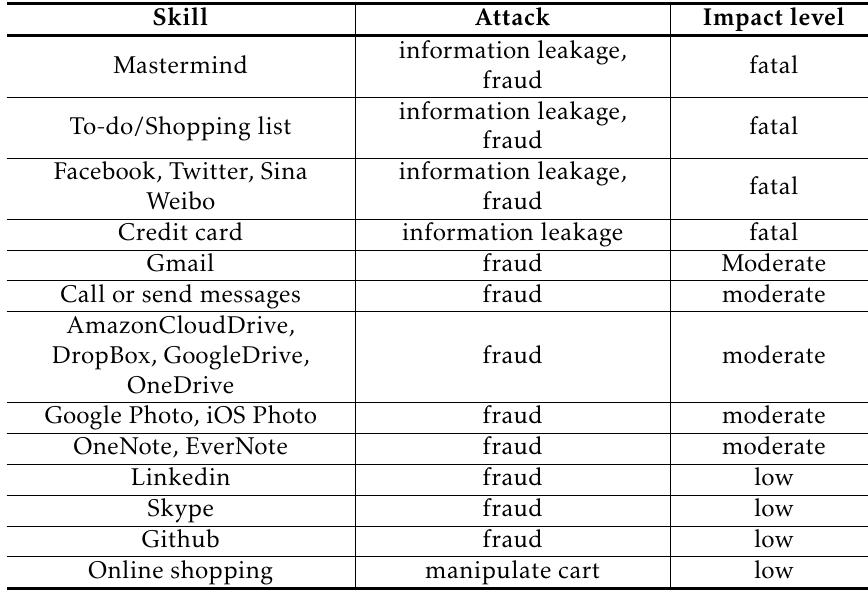
Table 3. Impact of attacking Echo in the virtual